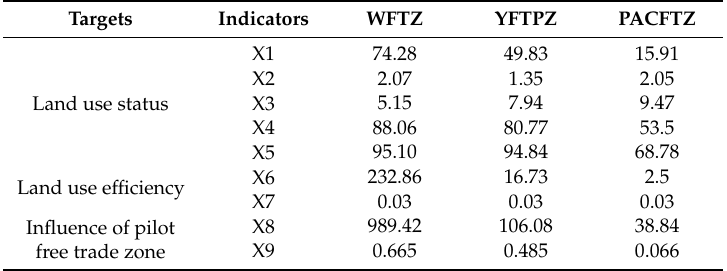
Table 3. Intensive land use in the SPFTZ evaluation indices data.